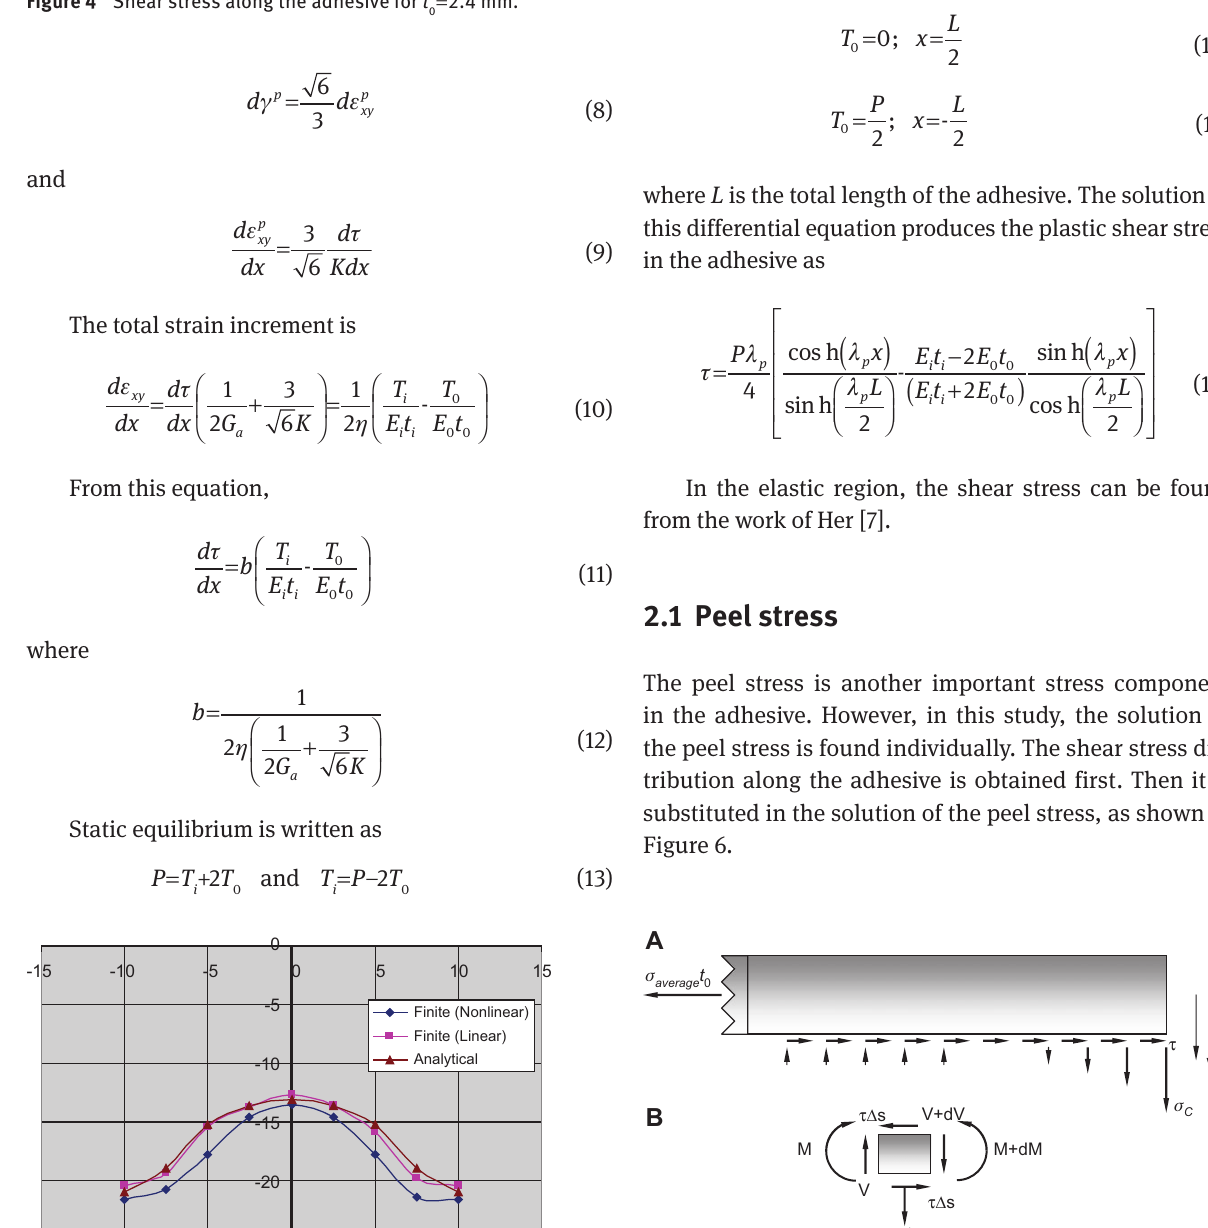
Figure 4 Shear stress along the adhesive for t